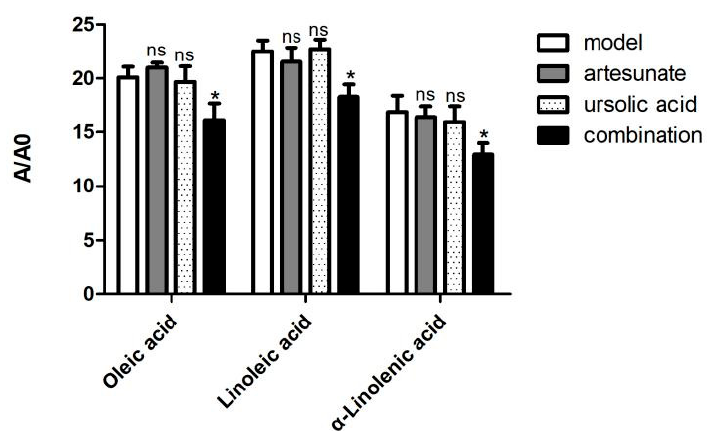
Figure 8. The relative intensity of oleic acids, linoleic acid, and α -linolenic acid of the model group and combination group (artesunate + ursolic acid) in the serum. A / A0 is expressed by its peak area normalized against that of the internal standard. Values are represented as mean ± SD. Significant difference vs. the model group (* p < 0.05, ns means there was no significant difference between the drug treatment groups and model groups).